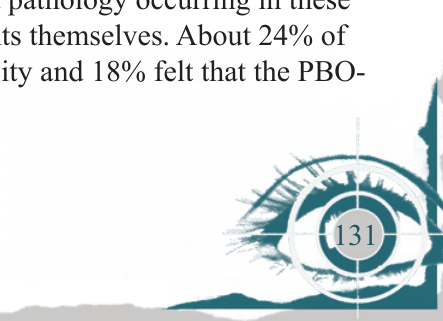
Figure 3: Responsibility for policing the sale of ready-made readers